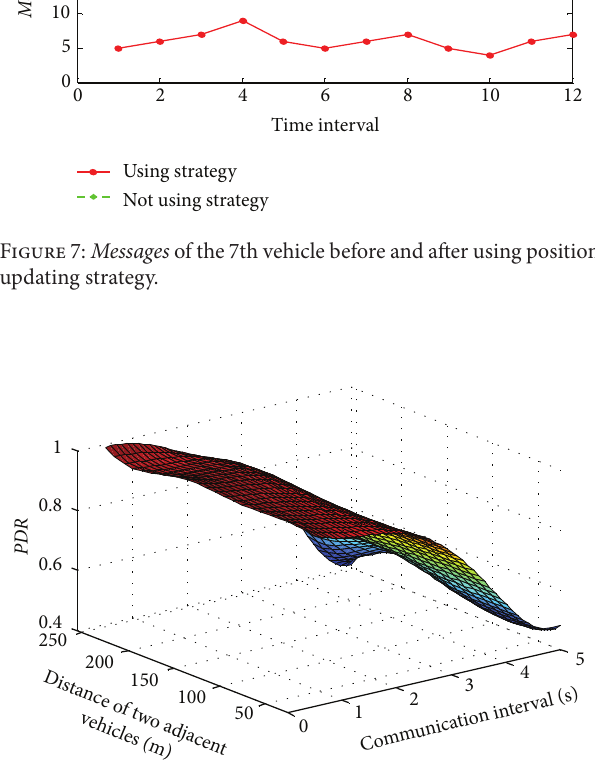
Figure 8: The PDR of not using repetition model decision algorithm (number